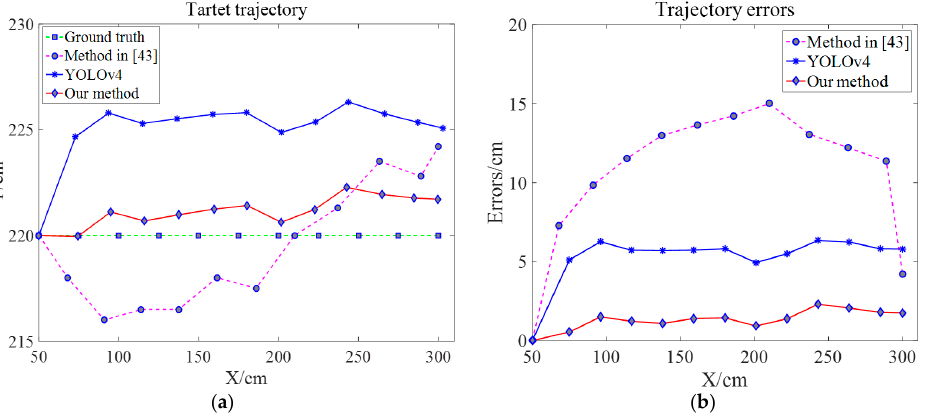
Figure 13. Trajectory and PTZ errors of the target on the horizontal channel. ( a ) Target trajectory. ( b ) Trajectory errors [43].